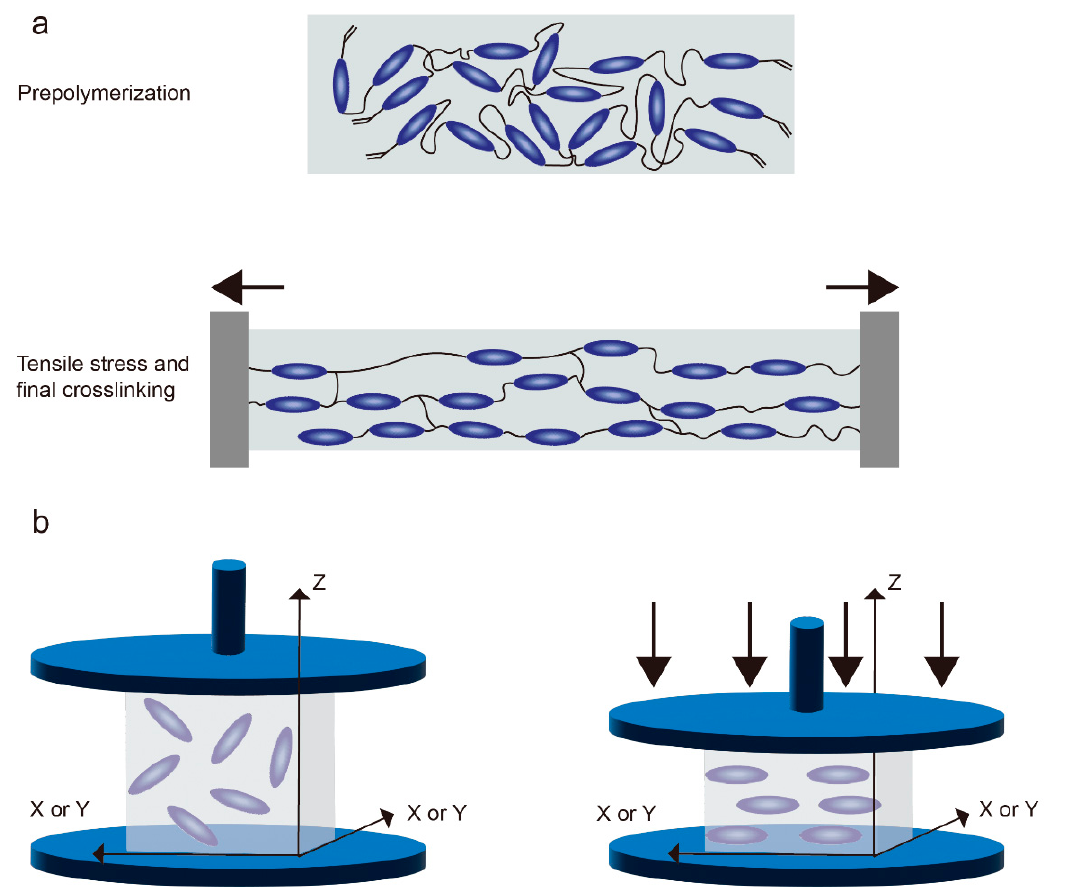
Figure 4. ( a ) Schematic diagram of LCE alignment by tensile stress. Mesogens will be aligned parallel to the direction of tensile stress. ( b ) Schematic diagram of LCE alignment by compressive stress. LC molecules will be oriented vertically according to the direction of the compressive stress.